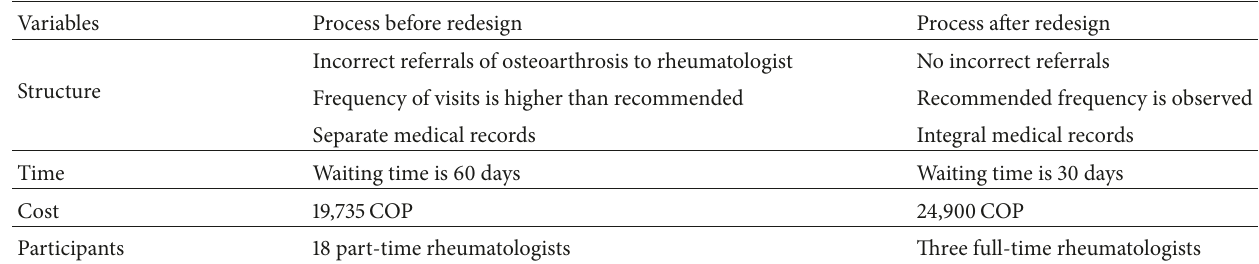
Table 2: BPM: Two versions of the process compared.